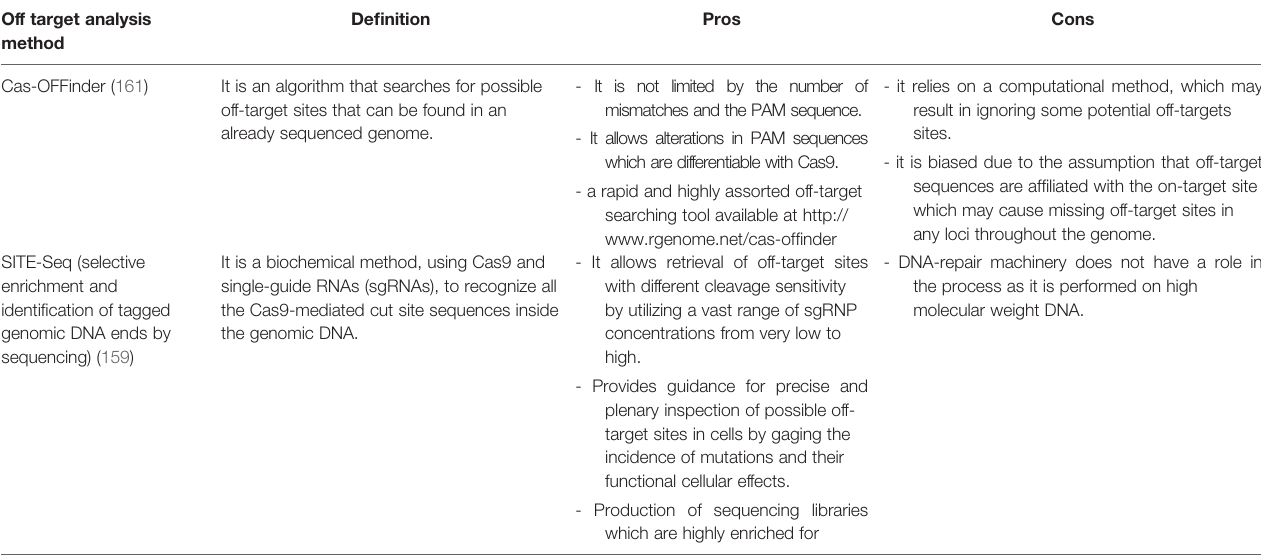
TABLE 2 | Current methods in off-target analyses of CRISPR edited immune